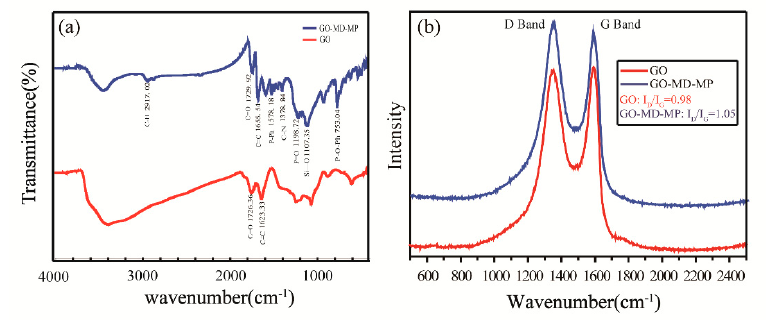
Figure 3. FT-IR ( a ) and Raman spectra ( b ) of graphene oxide (GO) and GO-MD-MP.